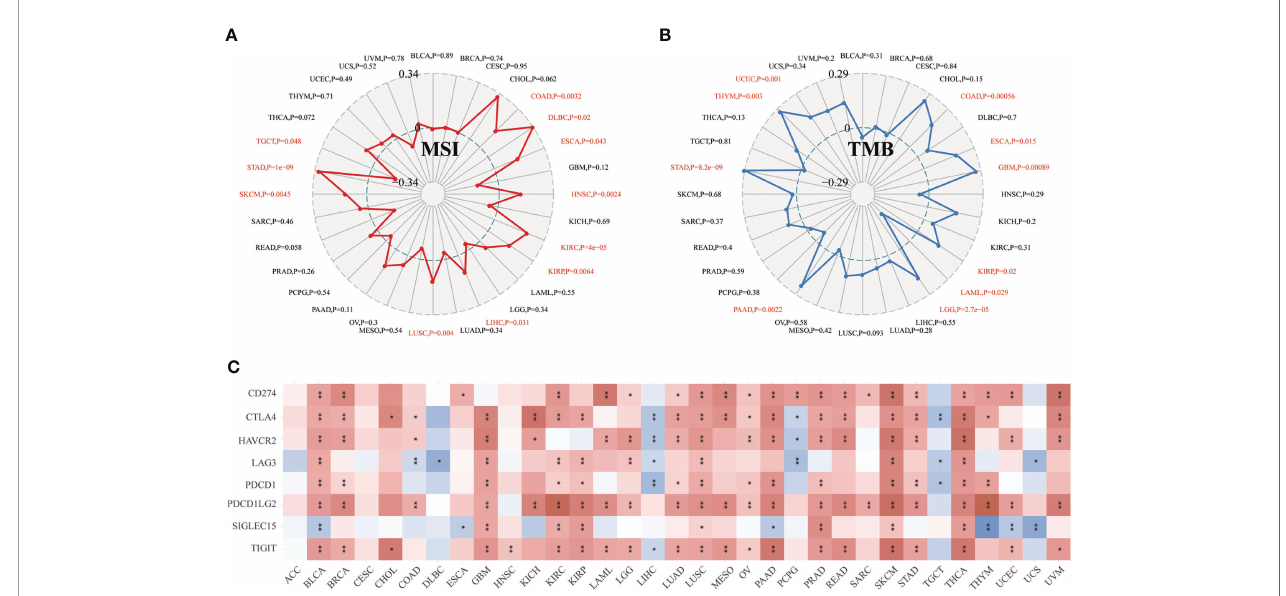
( Supplementary Figure 9C ), SKCM ( Supplementary Figure 9D ), COAD ( Supplementary Figure 9E ), BLCA ( Supplementary Figure 9F ), and BRCA ( Supplementary